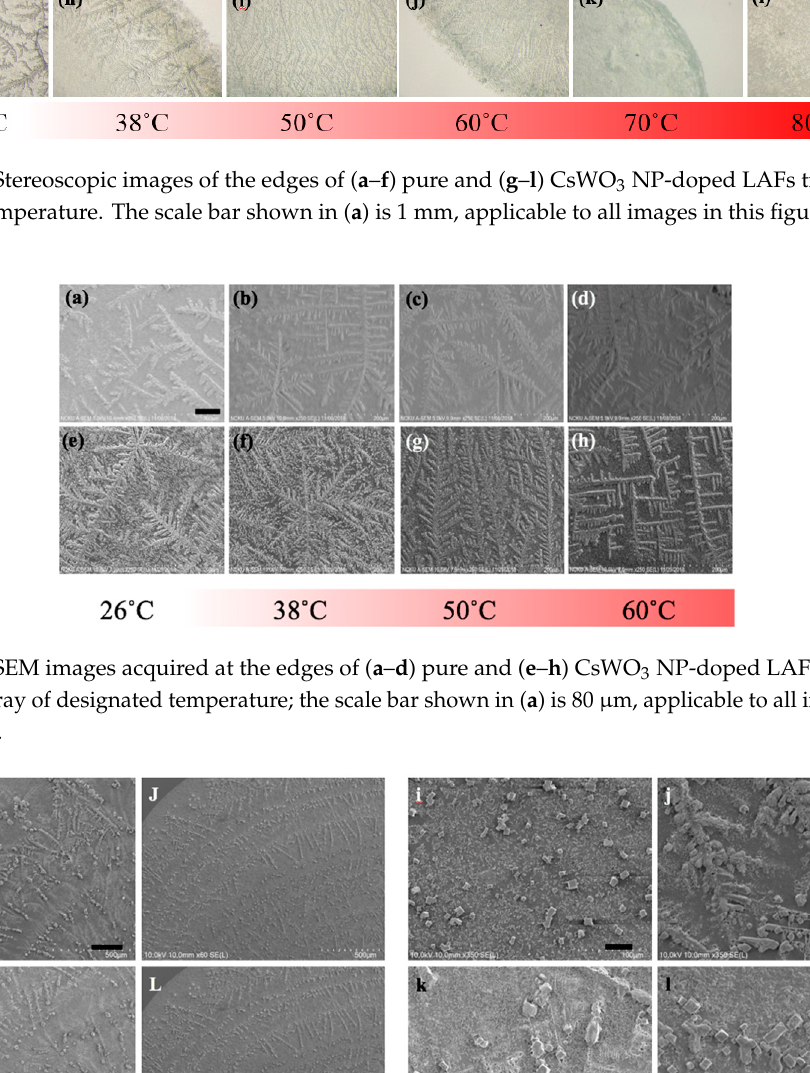
Figure 7. SEM images acquired at the edges of ( a – d ) pure and ( e – h ) CsWO 3 NP-doped LAFs treated with an array of designated temperature; the scale bar shown in ( a ) is 80 μ m, applicable to all images in this figure. Figure 8. SEM images of ( I , J ) LAFs and ( K , L ) fibrillary nanocomposites, treated with ( I , K ) 70 ◦ C and ( J , L ) 80 ◦ C, as well as ( i , j , k , l ) the corresponding zoomed-in scope of views are illustrated on left-hand and right-hand panels with scale bars of 200 µ m and 40 µ m,